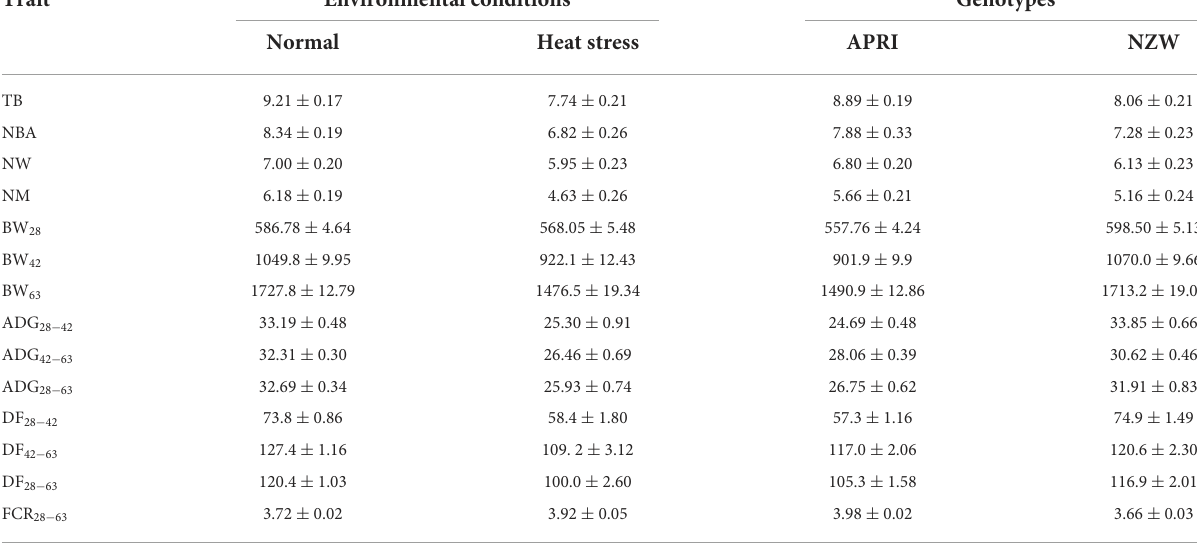
TABLE 2 Effects of heat conditions and genotypes on the litter and growth traits a .